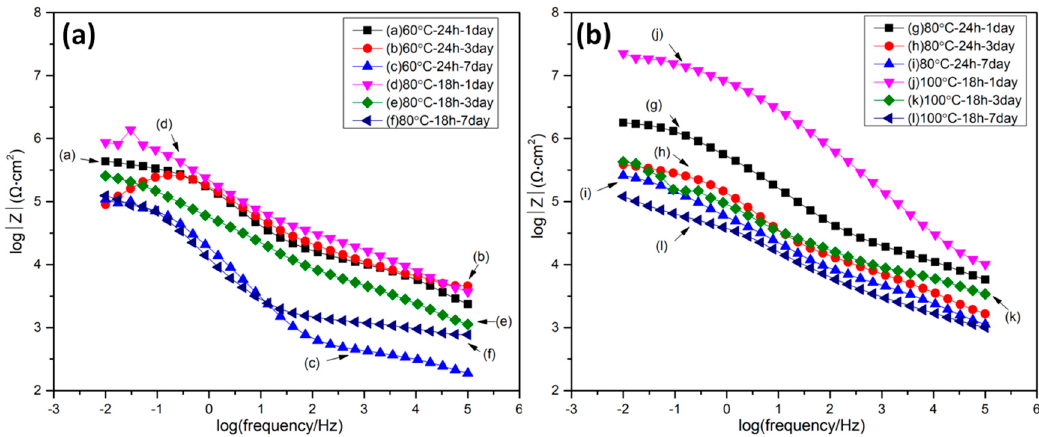
Figure 9. Bode plots of AA6082 samples, coated with MgAl–NO 3 LDH thin film after immersion